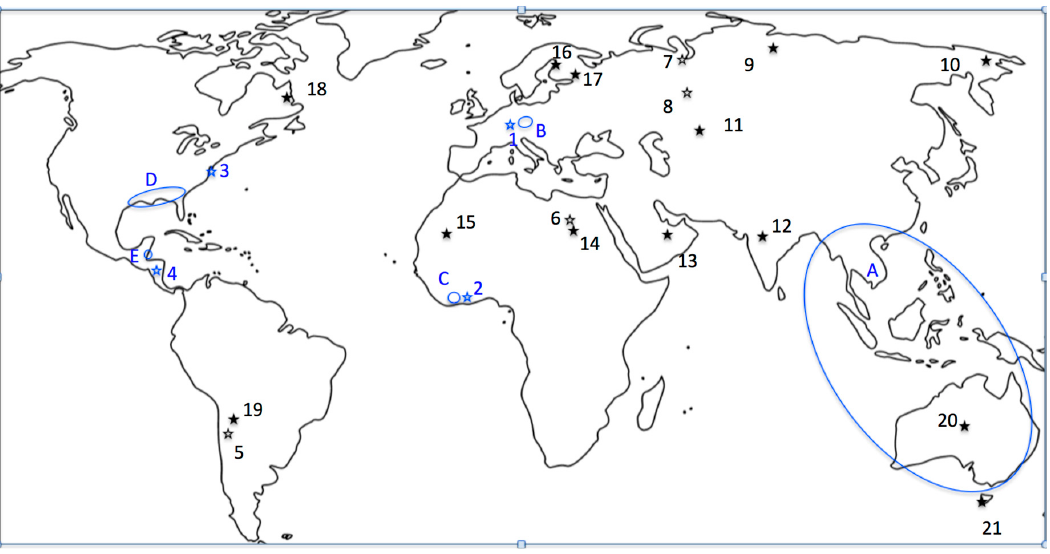
Figure 1. Map of tektite fields (blue contours: A —australasites; B —moldavites; C —ivoirites; D —bediasite-georgiaites; E —belizites), craters of possible origin for tektites (blue star: 1 —Ries; 2 —Bosumtwi; 3 —Chesapeake Bay; 4 —Pantasma), other impact glasses without known source crater